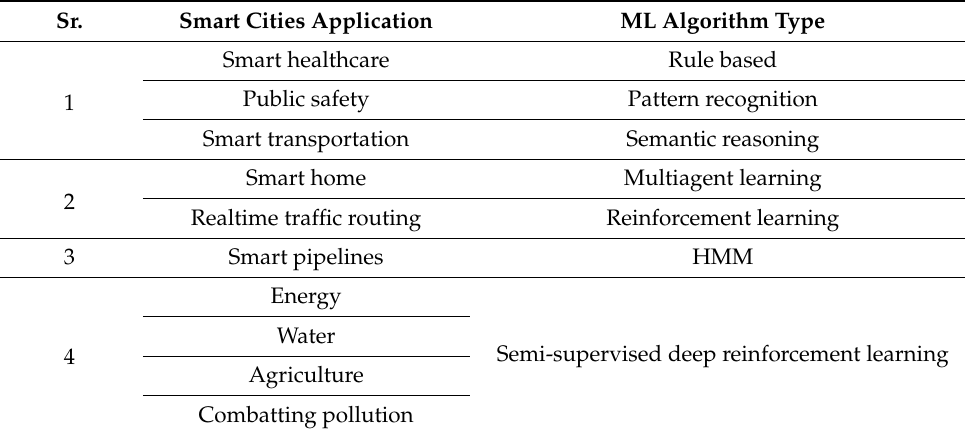
Table 2. Machine learning in context of smart cities